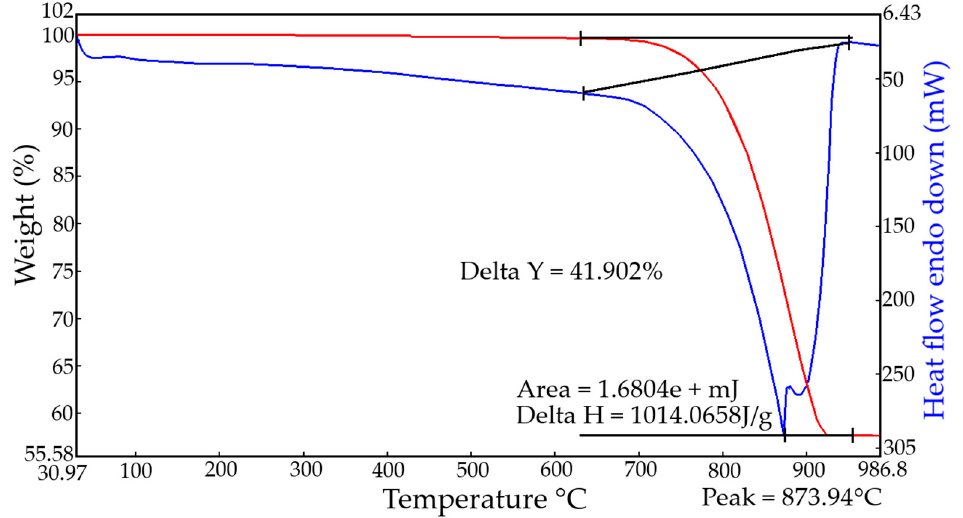
Figure 2. Thermogram of Balaklava deposit limestone sample.